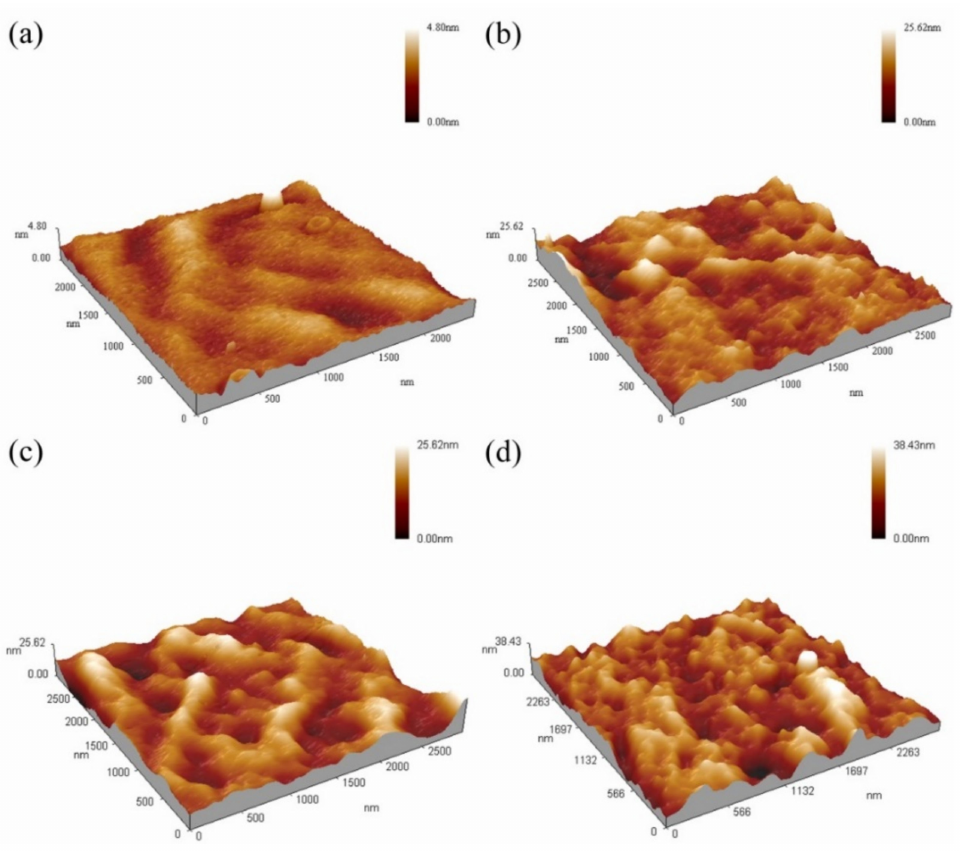
Figure 10. The 3D morphologies of the surfaces of Ag / HNTs / PUs nanocomposites ( a ) PU ( b )